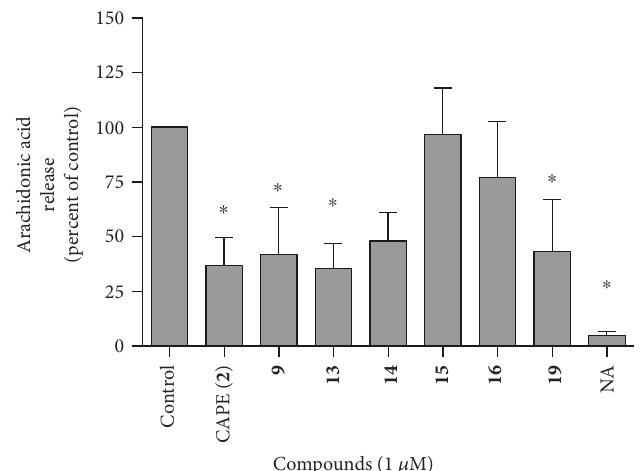
Figure 4: The impact of test compounds on the liberation of arachidonic acid in stimulated PMNL. Human PMNL were incubated with test compounds (1 μ M) or their diluent (control, DMSO 0.5%) for 5min. Stimulation was then initiated with the addition of 1 μ M thapsigargin, followed by an incubation at 37 ° C for 5min. The reactions were stopped with the addition of two volumes of cold MeOH and 300 ng of arachidonic acid-d , then samples were stored overnight at − 20 ° C. Free arachidonic acid was fi rst extracted on octadecyl columns, then 8 penta fl uorobenzylesters of arachidonic acid were prepared and samples were measured on GC-MS. Spontaneous release of AA was also measured in absence of thapsigargin (nonactivated, NA). ∗ Di ff erent from control as determined by one-way ANOVA with Dunnett ’ s multiple comparison test ( p < 0 05 ). Data are expressed as means ± SEM of at least 3 independent